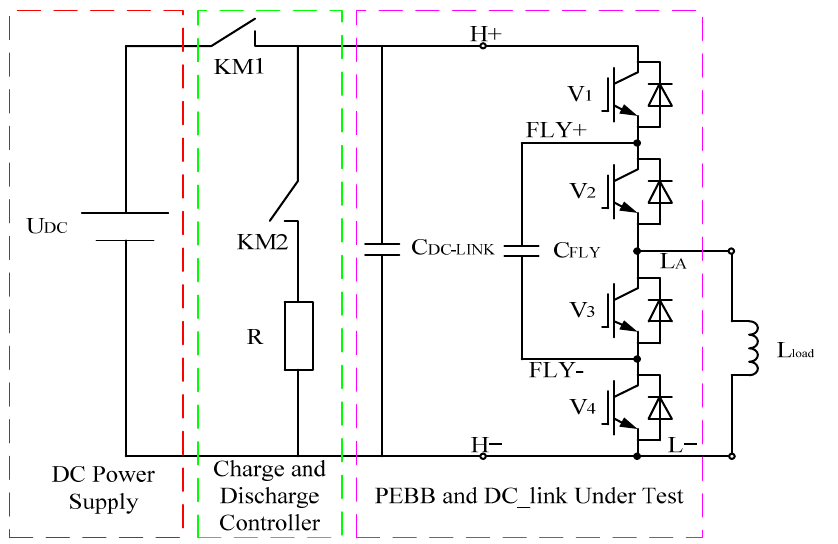
Figure 17. A Simplified schematic of the double-pulse test bench for the FC-3L-BDC phase-leg PEBB in buck mode.